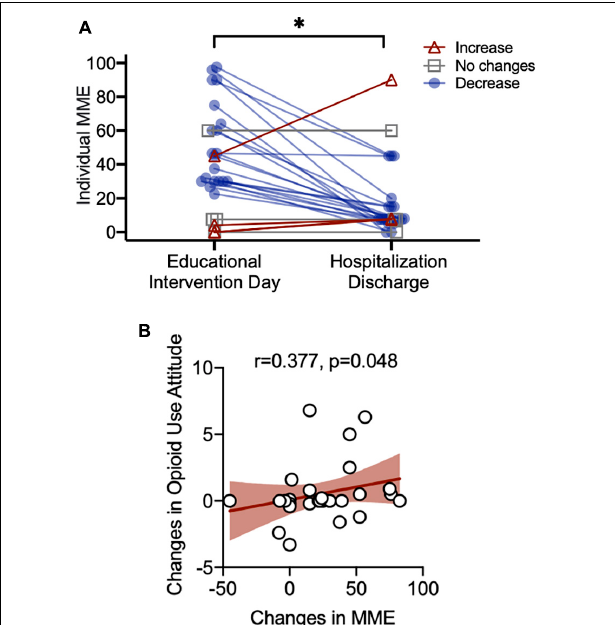
FIGURE 4 | Morphine milligram equivalents (MME) changes (A) . Controlling for age, sex, and race, post-education opioid prescription (minimal amount) were significantly lower than the pre-education actual opioid intake ( F 1 , 24 = 4.53, unadjusted p = 0.044). Attitudes toward opioids and MME reductions (B) . Spearman correlation between reduction in attitudes toward opioids safety/needs and MME reductions (Spearman r = 0.377, unadjusted p = 0.048). ∗ Indicate statistical